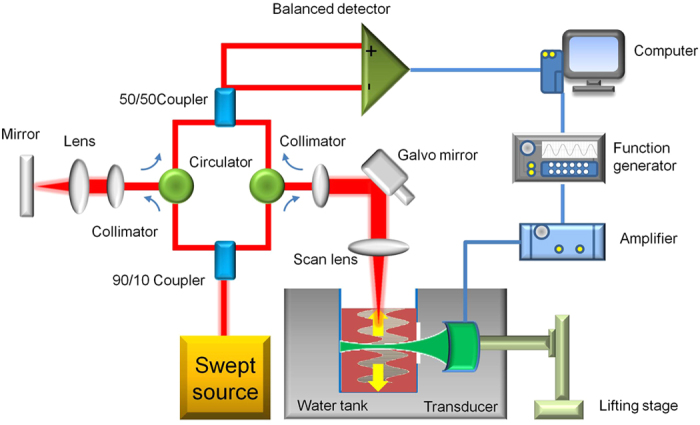
The schematic of the ARFOE-OCE system, including the swept source OCT unit and ultrasonic excitation unit.The vibration perpendicular to the OCT detection direction is detected by a Doppler variance method, and the shear wave propagating parallel to the OCT detection direction is measured by M-scans. The blood is filled to a box with a window of plastic wrap for the ultrasound wave passing. The box and the transducer are immersed in water for impedance matching of the ultrasound wave into the blood sample. Only the container contacts with the blood sample.